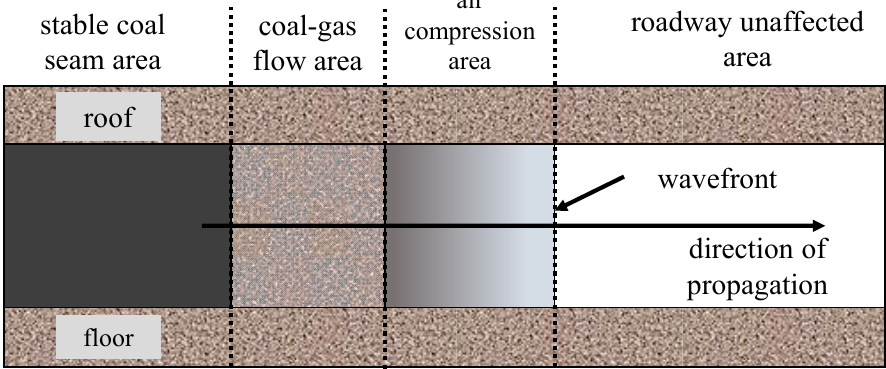
Figure 3. Schematic diagram of a coal-gas outburst. After the failure of the weak layer at the outburst mouth disappears, the pulverized coal-gas in the high-pressure space of the coal seam are released and freely migrate to the roadway space. The coal-gas flow will first form in the coal seam. The initial coal-gas flow first compresses the roadway air at the outburst port, and as the coal-gas flow moves, its interface with the air continues to move forward (right side). The compressed roadway air moves forward and compresses the more forward roadway air. The front of the compressed roadway air is called the outburst wave front. The range between the wave front and the coal-gas flow is the air compression zone. The roadway in front of the wave front has not been disturbed by the outburst, which is called the temporarily unaffected area. The air parameters in the area are stable and maintain initial parameters. The moving speed of the wave front is the development speed of the influence range of a coal and gas